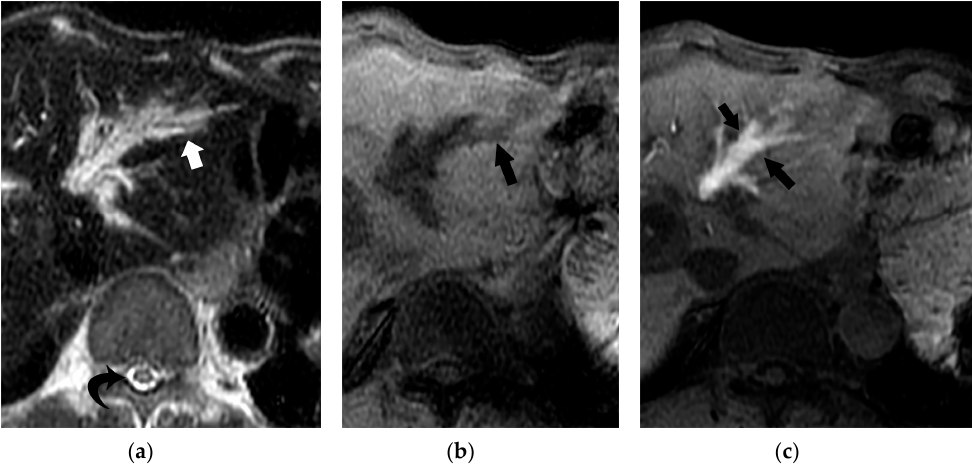
Figure 15. MR findings of BDN. ( a ) On T2-weighted MRI, BDN (arrow) on the left lateral lobe of the liver shows thick tubular hyperintensity, and the degree of hyperintensity is not so high compared to